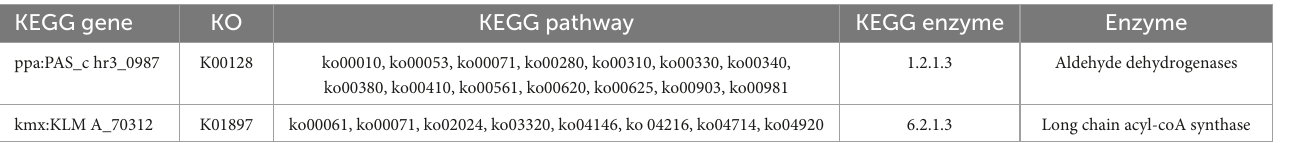
TABLE 6 Key genes and enzymes involved in the degradation of fatty acid in Wickerhamomyces anomalus Y12-3. KEGG gene KO KEGG pathway KEGG enzyme